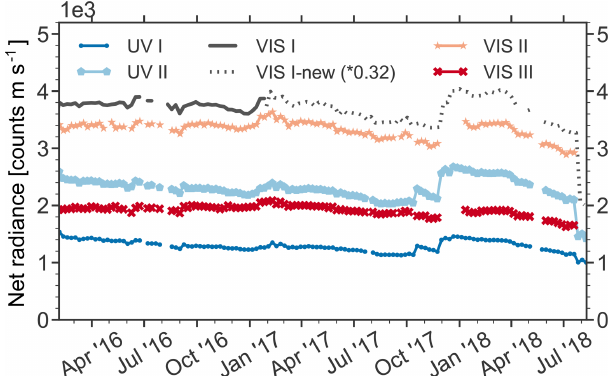
Figure 11. Evolution of the net radiance of reference spectra in the NMIII setup over time for the five spectral ranges UV I through VIS II defined in Table D1. The average intensity value (in counts) of the reference spectra in the different measurement windows was cor- rected for background light by subtracting corresponding reference background spectra (light source blocked and shortcut in front of the fibre end in the telescope). Following this, weekly medians were calculated. Since the grating was changed in February 2017 in the VIS I window, the recorded radiances (which due to the lower dis- persion of the new grating were about 3 times higher) were adjusted to that of the first grating (dotted line). Maintenance was performed on a monthly basis (as far as meteorological conditions allowed) and optical components (filters in the light source) were exchanged after roughly 1 year of operation. This resulted in temporarily en- hanced